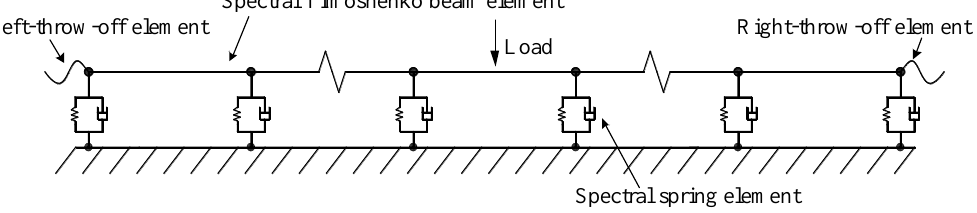
Figure 3. The element division using the spectral element method.